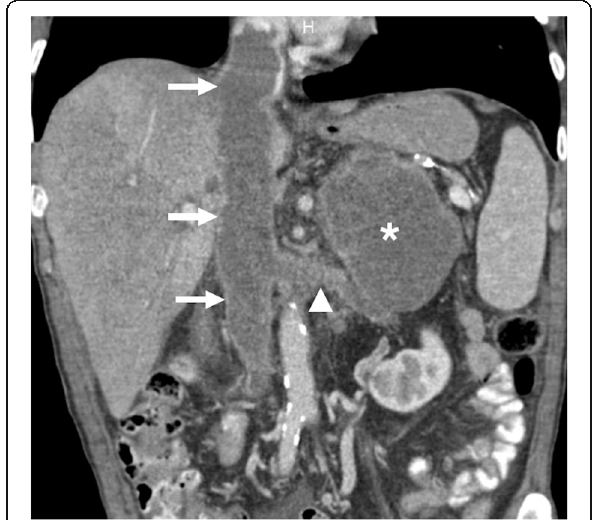
Fig. 9 A 60-year-old male with no past medical history presented with left flank pain and weight loss. Coronally reformatted postcontrast CT image shows a left adrenal mass (asterisk) invading the left renal vein (arrowhead) and IVC (arrows). Surgical resection revealed adrenocortical carcinoma with tumor thrombus extending into the left renal vein and